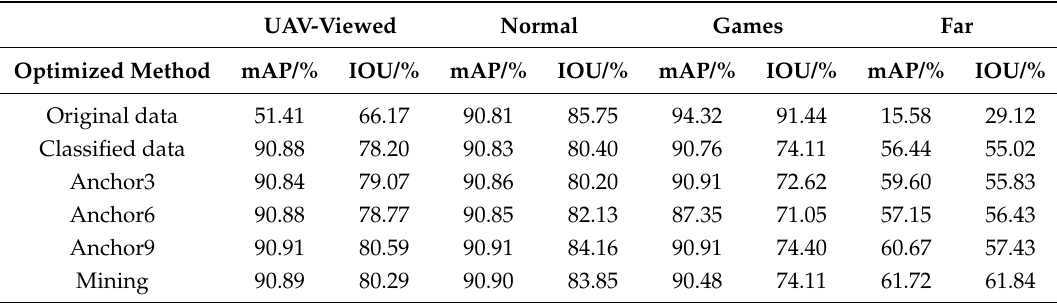
Table 1. Mean average precision (mAP) and intersection over union (IOU) performance on UAV-YOLO using different optimized training